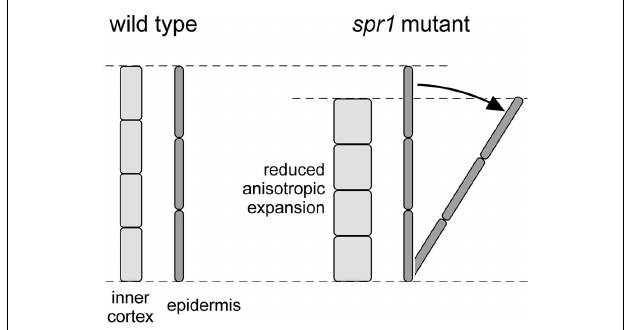
FIGURE 1 | Geometric model of the interactions of tissues involved in twisting growth in Arabidopsis wild-type and spr1 hypocotyls; redrawn after Furutani et al. (2000, Fig. 11 on p. 4451). We cannot describe this graph any better than Hashimoto (2002, p. 806) did: “In the wild-type organ axis, the sum of inner cell length is equal to the sum of epidermal cell length, whereas inner cells of spiral mutant organs are defective in anisotropic growth and the total longitudinal length is shorter than that of epidermal cells.To compensate for this difference, the mutant epidermal cell files must